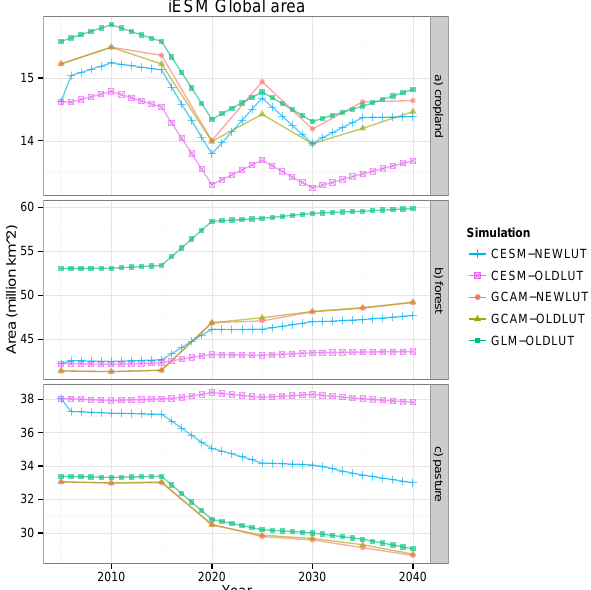
Figure 7. iESM land use and forest area. The GLM-NEWLUT for- est and pasture data are nearly identical to the GLM-OLDLUT data and are not shown for clarity. Similarly, the GLM-NEWLUT crop- land data track the GCAM-NEWLUT data, but with the same offset as for the GLM-OLDLUT data.